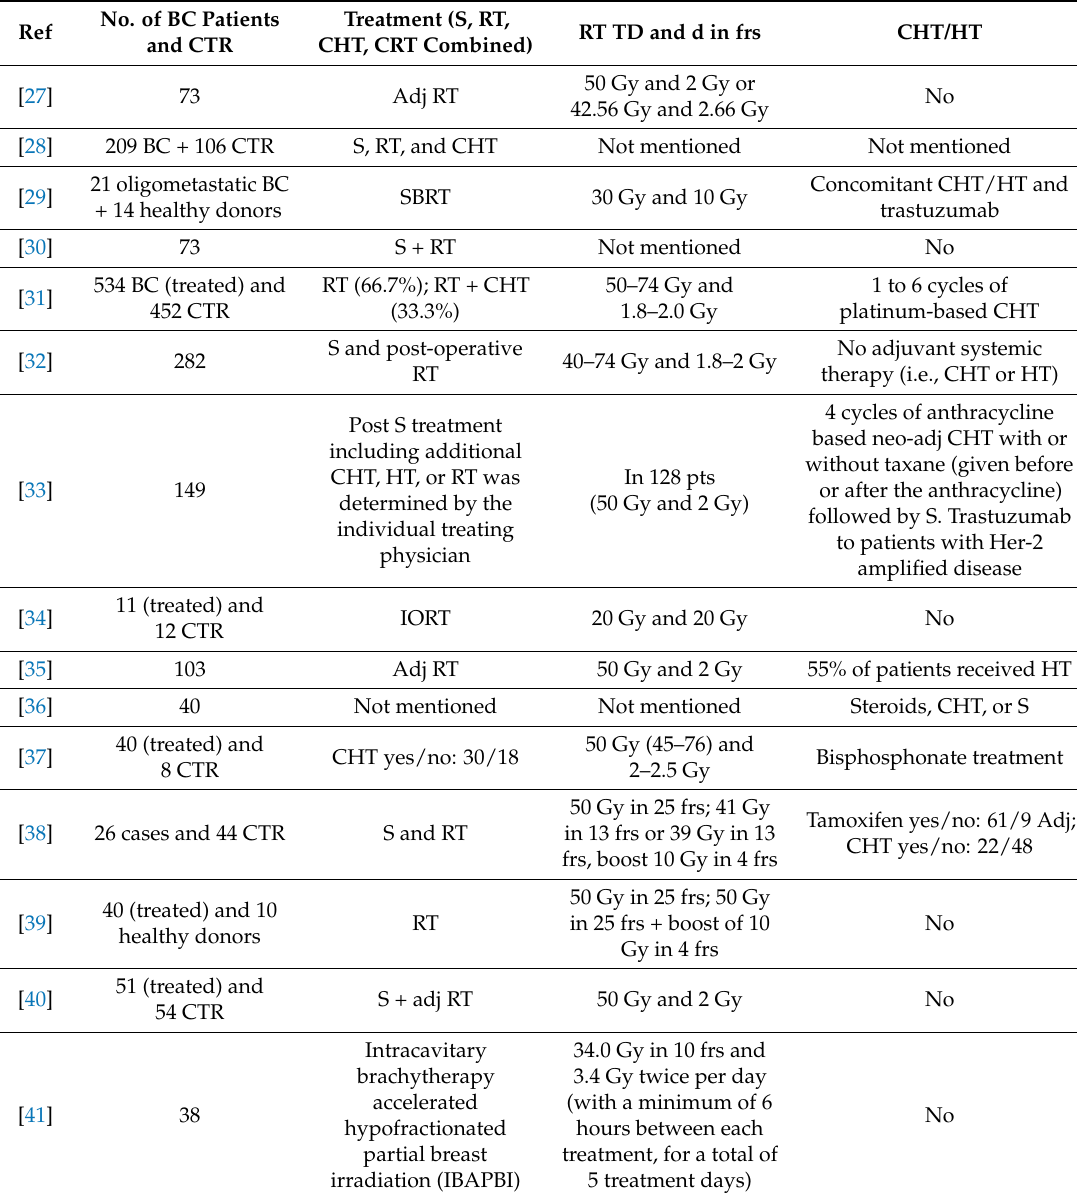
Abbreviations for Table 1: adjuvant (adj); breast cancer (BC); chemotherapy (CHT); combined chemo-radiotherapy (CRT); control (CTR); fractions (frs); Gray (Gy); human epidermal growth factor receptor-2 (Her-2); hormone therapy (HT); intracavitary brachytherapy accelerated hypofractionated partial breast irradiation (IBAPBI); intraoperative radiotherapy (IORT); radiotherapy (RT); surgery (S); stereotactic body radiation therapy (SBRT); total dose (TD). See Abbreviation list for other